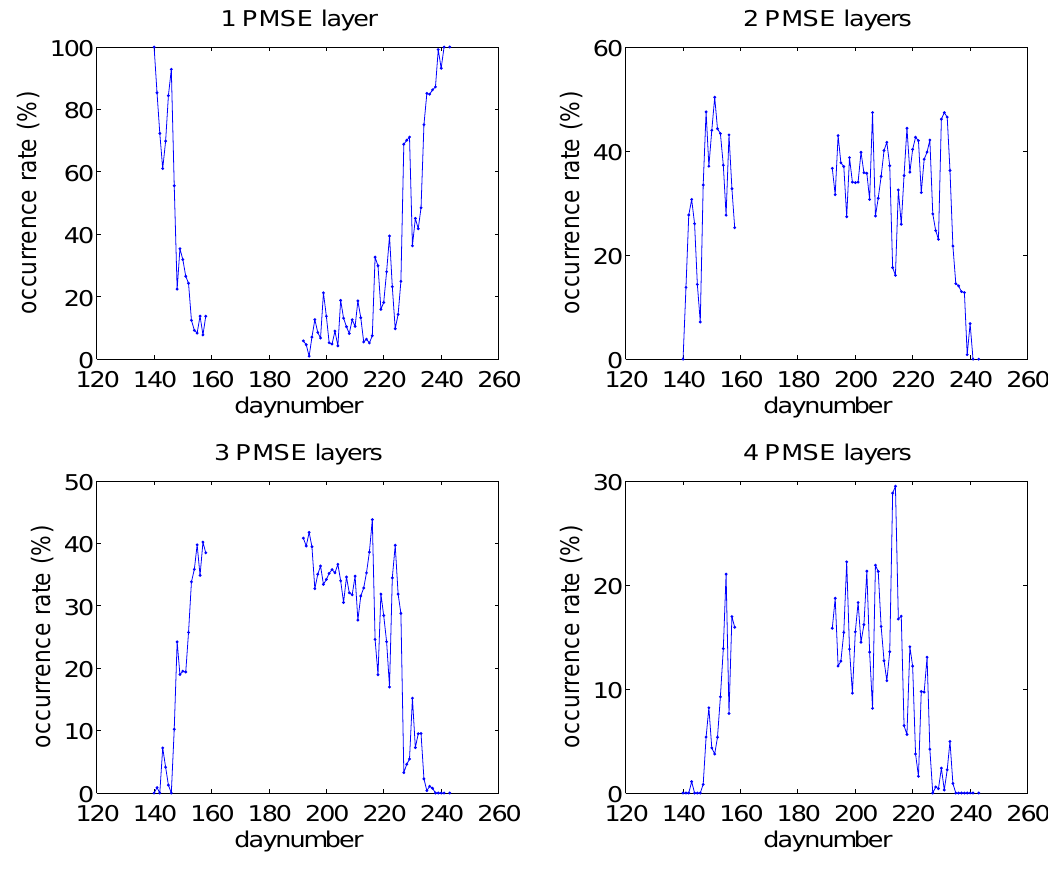
Fig. 10. Seasonal variation of the relative rate for the occurrence of 1, 2, 3 or 4 layers in all PMSE events during the year